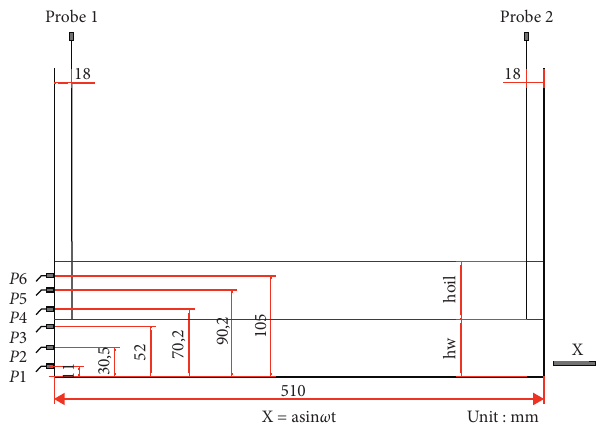
Figure 2: The layout of the test